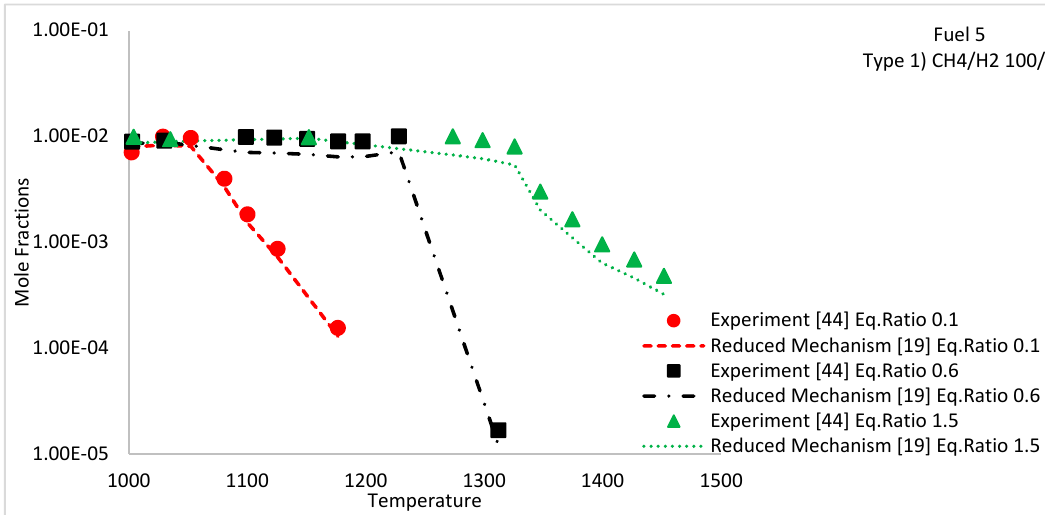
12 of 23 Figure 6. Comparison of the calculated laminar flame speed using the reduced mechanism [19] and